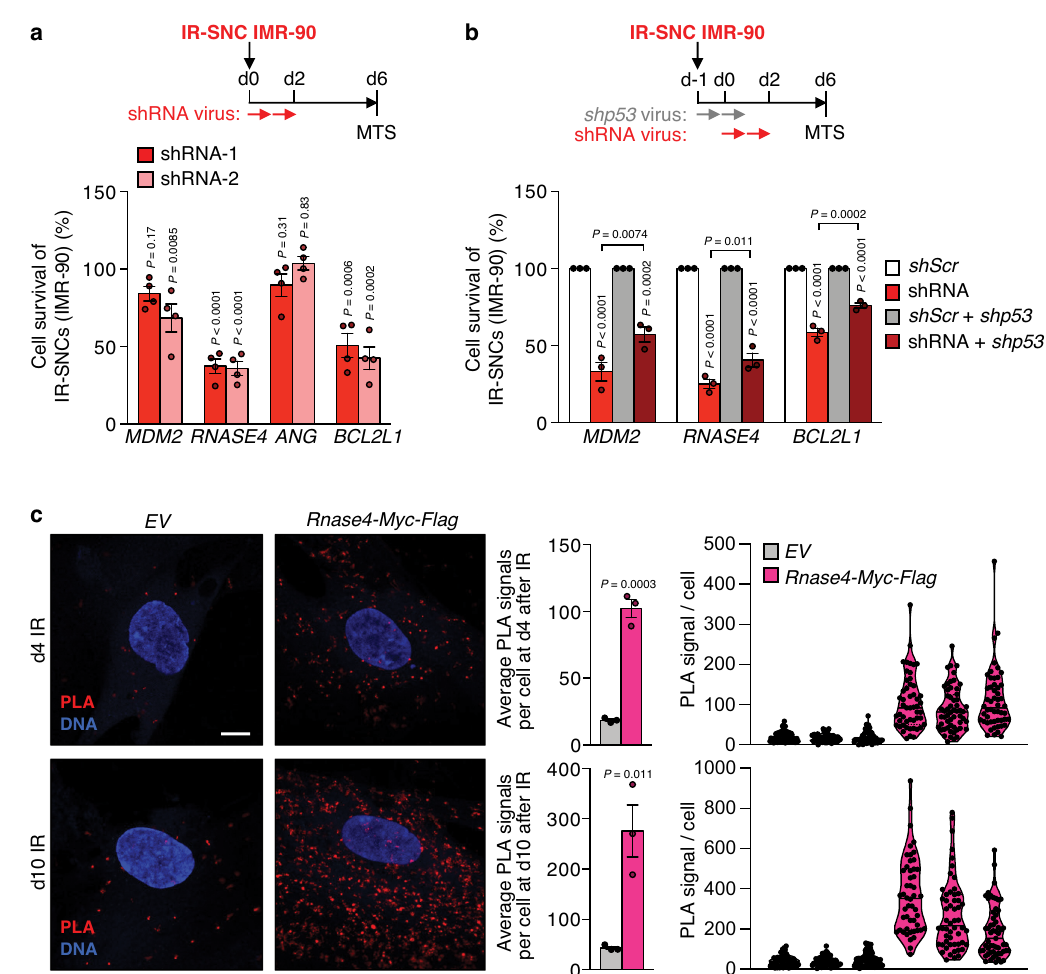
Fig. 9 Cytoplasmic RNASE4 binds to and inhibits p53 in human senescent fi broblasts. a Experimental approach and percentage survival of IR-senescent IMR-90 cells 6 days after knockdown of the indicated genes as assessed by MTS assay. Comparisons were made to senescent IMR-90 cells of same cultures infected with Scr- shRNA (100%). b as in a but comparisons were made to senescent IMR-90 cells of same cultures infected with Scr- shRNA or Scr - and p53 -shRNA (100%). c Representative images and quanti fi cation of proximity ligation assay (PLA) to assess spatial interaction of p53 and Myc- Flag-tagged RNASE4 in indicated irradiated IMR-90 cells. Violin blot shows distribution of PLA signals per cell per IMR-90 replicate. One experiment was performed. Scale bars, 10 μ m. Data represent means ± SEM. n = 4 a or n = 3 b independent experiments with each n being an average of 3 technical IMR- 90 replicates, n = 3 technical IMR-90 replicates from 1 experiment in c . Statistics: one-way ANOVA with Sidak ’ s correction in a , b , two-tailed, unpaired t - tests in c . Source data are provided as a Source Data fi